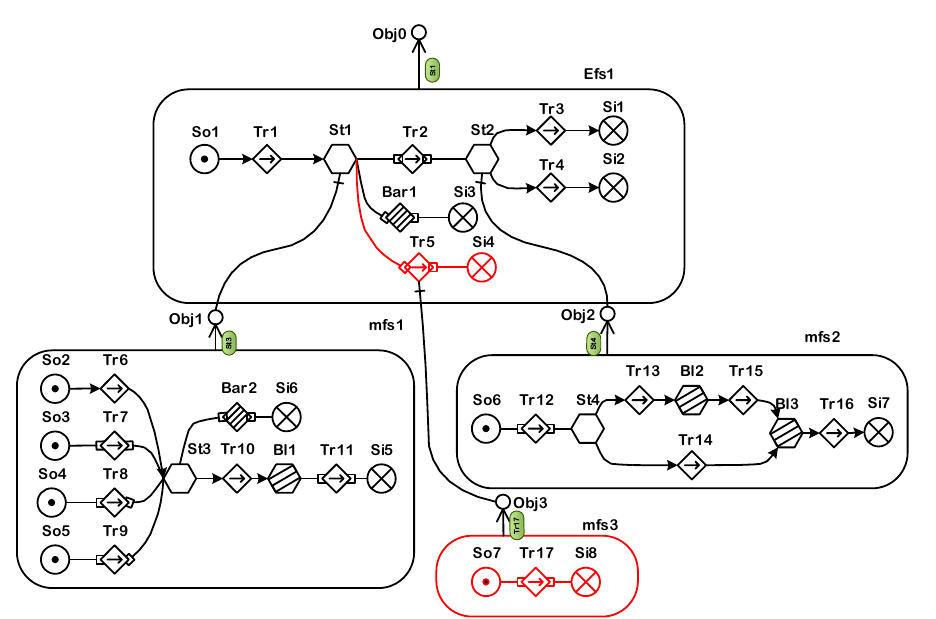
Figure 7. MFM model of maintaining reactor core cooling. The red part in the Figure 7 represents the failed of RHR system.